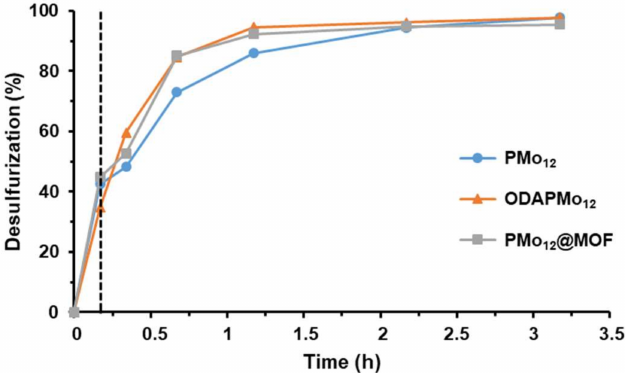
Figure 5. Desulfurization of a multicomponent model diesel in a biphasic system (diesel/[BMIM][PF 6 ]) showing the initial extraction (before the dashed line) and the catalytic stage (after the dashed line) using PMo 12 , ODAPMo 12 and PMo 12 @MOF as catalysts at 50 ◦